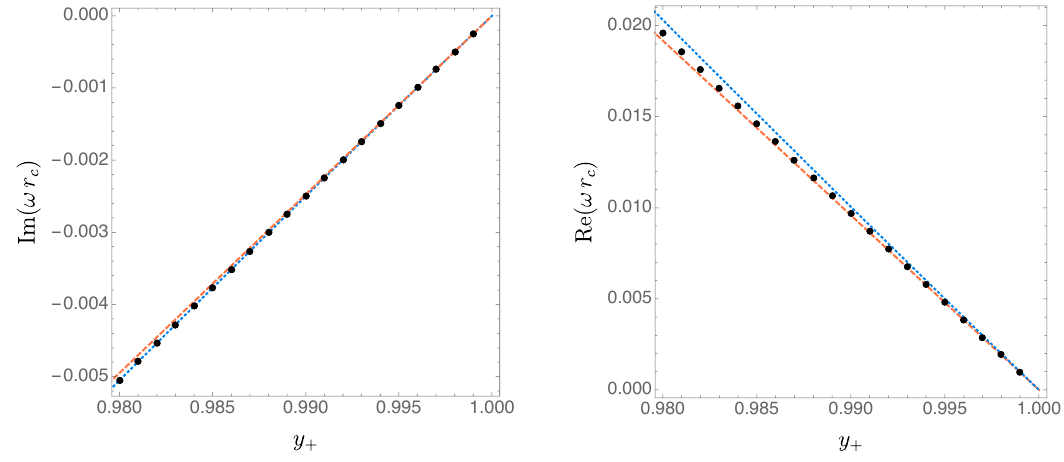
Figure 10 . Photon sphere family of modes (cid:8) (cid:0) with ‘ = 2, n = 0 and the Nariai limit for RNdS black holes with Q=Q ext = 0 : 0999. In both plots, the dashed orange line refers to the Nariai analytical prediction (A.2) for ‘ = 2 ; n = 0, while the dotted blue curve is the analytical geometric optics/WKB photon sphere prediction (5.11) for ‘ = 2 ; n = 0. Left panel: Im( ! r c ) as a function of y + close to the Nariai limit y + (cid:24) 1. Right panel: Re( ! r c ) as a function of y + close to the Nariai limit y + (cid:24)